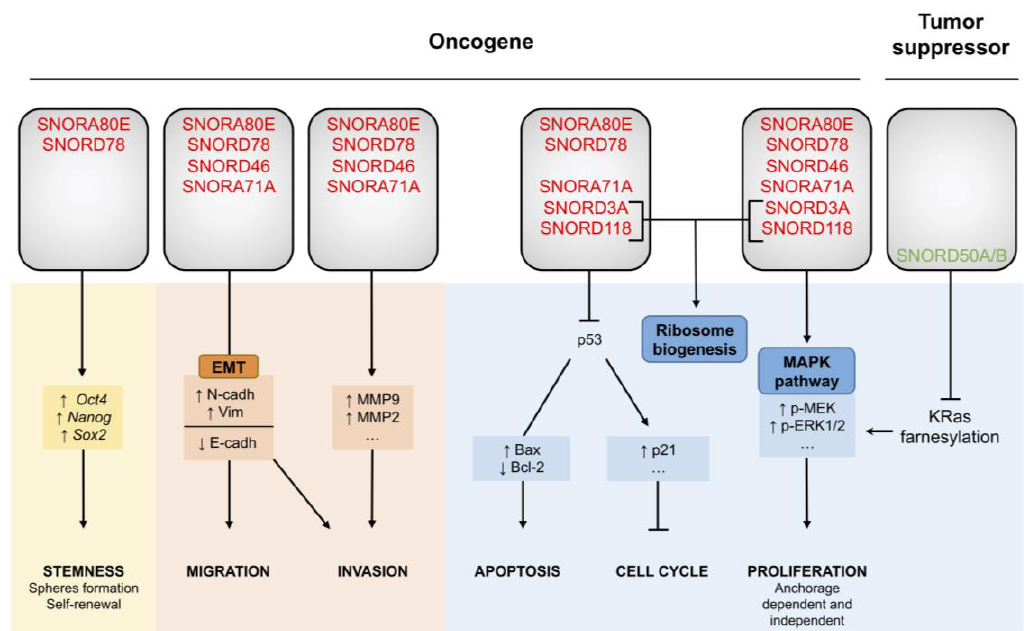
Figure 2. Biological functions of snoRNAs in lung cancer. snoRNAs act either as oncogenes or tumor suppressors. Experimental dysregulation of these snoRNAs affects different cellular processes (bottom panel), such as cell mobility, stemness and cell viability, by modulating different signaling pathways (middle panel). Altogether, this diagram summarizing the snoRNAs-related cellular functions reported in lung cancer, supports their key role in lung tumorigenesis and progression. snoRNAs overexpressed in lung cancer tissues compared to non-cancerous tissues are highlighted in red, underexpressed in green.